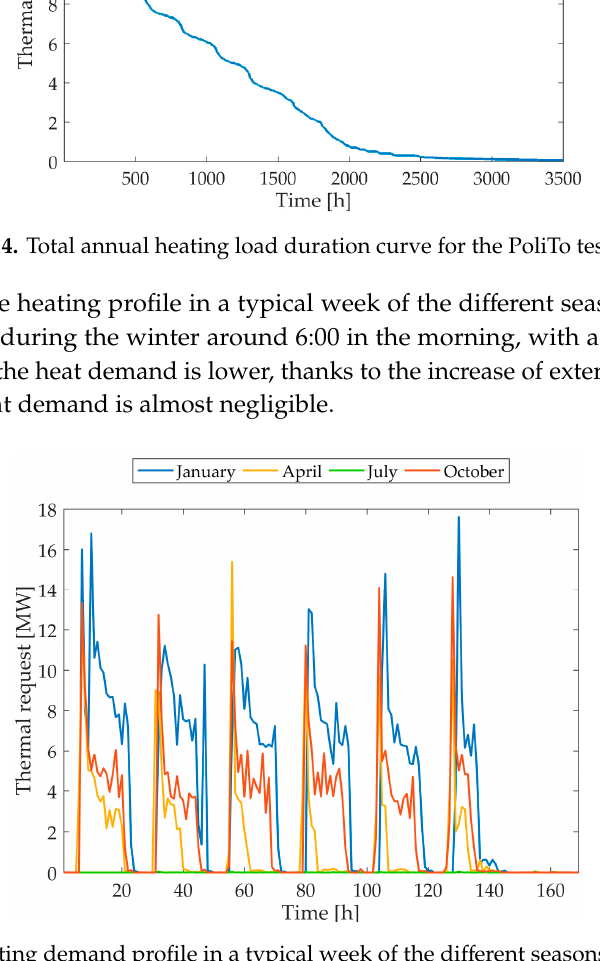
Figure 5. PoliTo heating demand profile in a typical week of the different seasons: winter (blue line), spring (orange line), summer (green line) and autumn (red line).